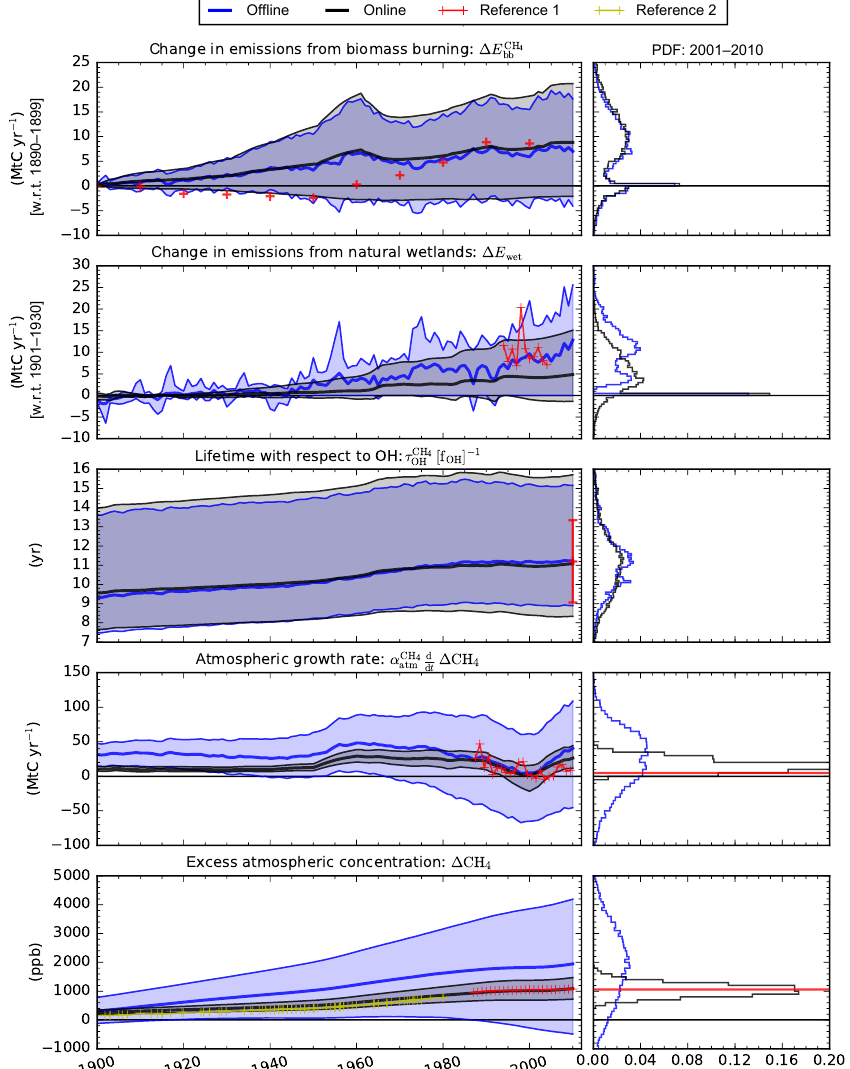
Figure 6. Results of our simulations with OSCAR, for methane, with the same format as for carbon dioxide. References are ACCMIP (Lamarque et al., 2010) for biomass burning, WETCHIMP (Melton et al., 2013) for wetlands, Prather et al. (2012) for the lifetime and 90% uncertainty range (calculated as 1.645 times the 1 σ uncertainty), and AGAGE (Prinn et al., 2013) for the atmospheric growth rate and concentration. Reference 2 denotes Law Dome ice cores (Etheridge et al., 1998; MacFarling Meure et al., 2006, using the NOAA04